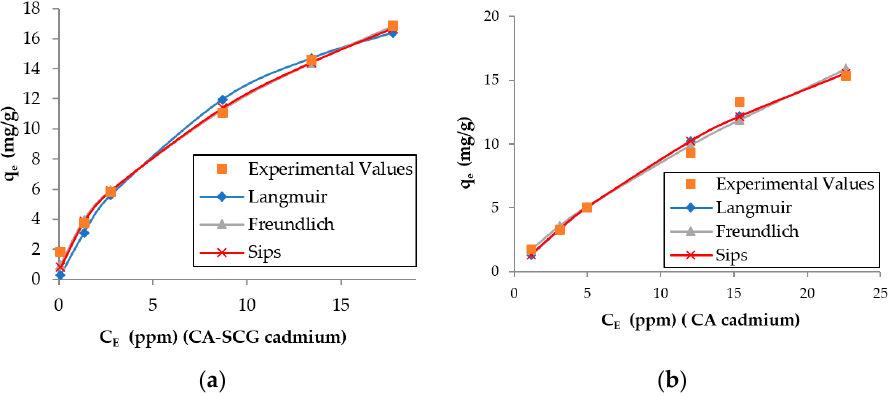
Figure 10. Plots of the results of the adsorption models for each adsorbent and the experimental values for cadmium: ( a ) CA beads and ( b ) CA–SCG beads.